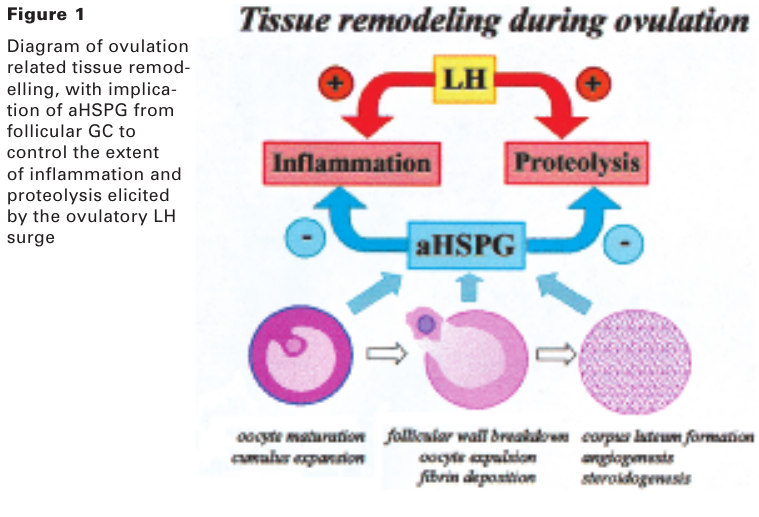
Figure 1 Diagram of ovulation related tissue remod- elling, with implica- tion of aHSPG from follicular GC to control the extent of inflammation and proteolysis elicited by the ovulatory LH